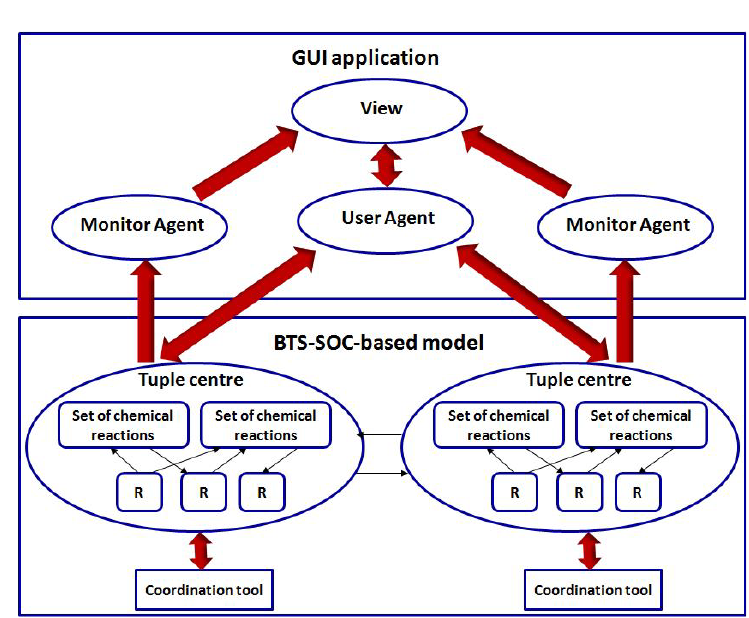
Figure 1: A high-level architecture for the BTS-SOC-based bioinformatics